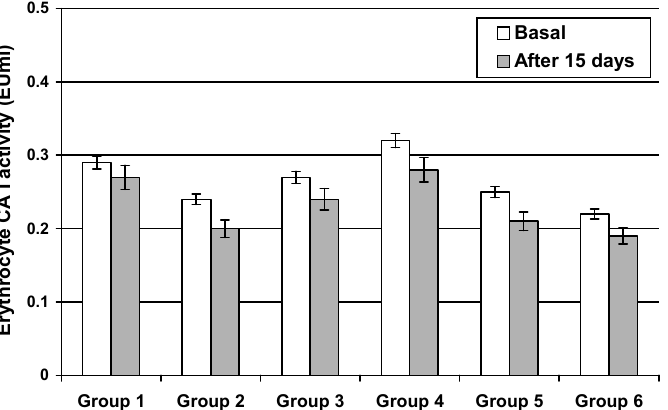
Figure 2. Erythrocyte Carbonic Anhydrase I activity after 15 days of treatment with carbamazepine (Group 1), phenytoin (Group 2), valproate (Group 3), primidone (Group 4), clonazepam (Group 5), and ethosuximide (Group 6). The isozyme activity presented a slow decrease as compared to the initial values. Values are means ± SEM; n = 20 patients.